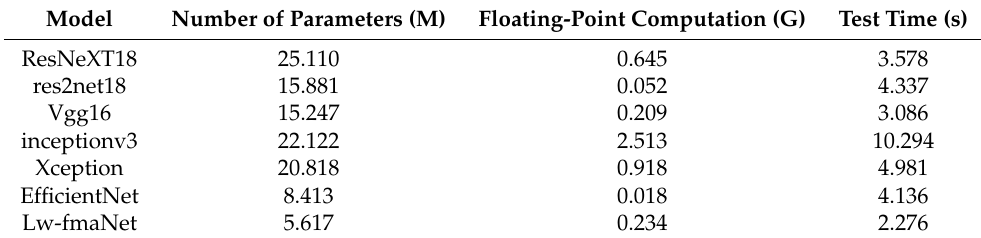
Table 7. The number of parameters, the amount of floating-point computation, and the test time of each model.